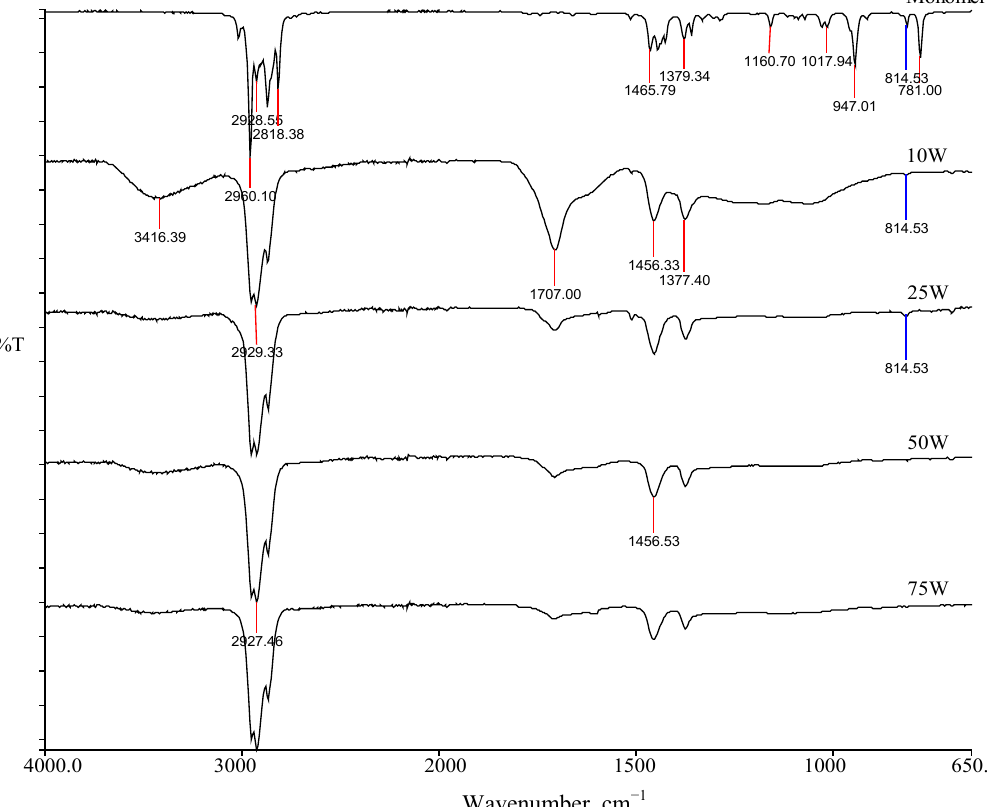
Figure 2. FTIR spectra (% transmittance vs. wavenumber, cm − 1 ) for γ -Terpinene monomer and pp–GT thin films.